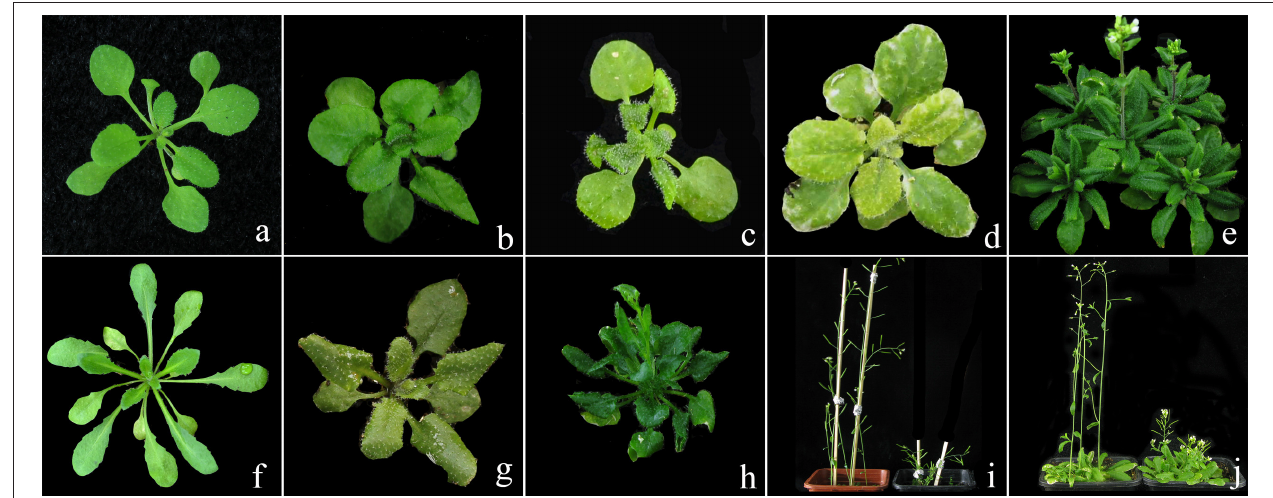
FIGURE 1 | Phenotypes of the nine re-sequenced lines that had stable mutation traits induced by CIB irradiation. (a) : wild type (ecotype Col); (b–j) : mutagenesis progeny lines in the corresponding order of C7, C197, C352, C357, C600, C828, C941, C116 and